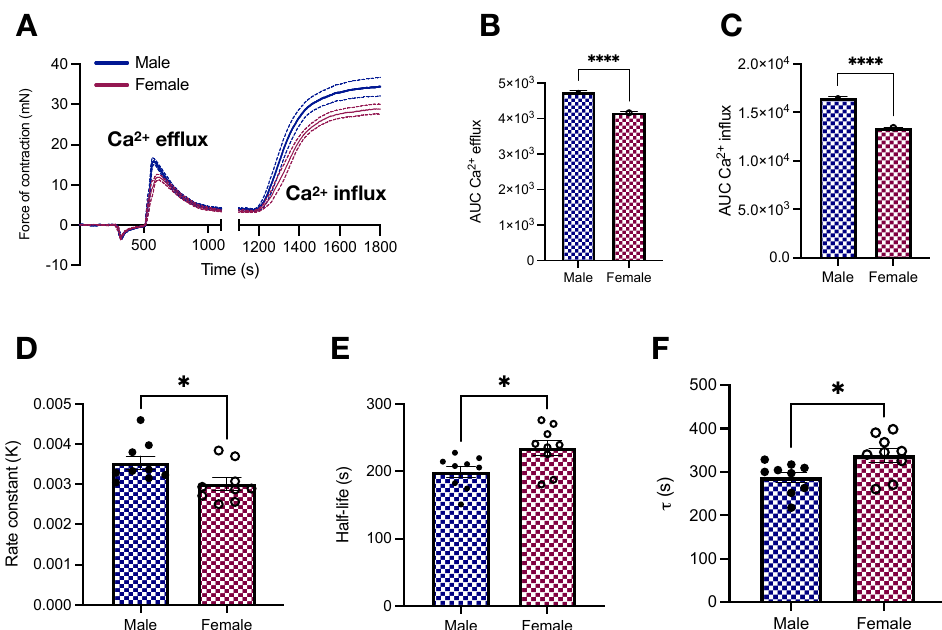
Figure 4. Vascular responses to calcium efflux and influx in male and female young Wistar rats. ( A ) Calcium protocol and ( B , C ) area under the curve. All samples were stimulated with phenyle- phrine (10 − 5 mol/L). In A, data points were sampled every second. The continuous line represents the mean, and the dashed lines depict SEM. The transient relaxation curves were fitted to a one-phase decay exponential model to reveal the rate constant κ ( D ), half-like ( E ), and τ ( F ). Data are presented as means ± SEM, n = 9–10. * p < 0.05 and **** p < 0.0001 using two-tailed Student’s t -test. 2.4. Elastin and Collagen Levels in the Aorta of Young Male and Female Wistar Rats The ECM, the non-cellular component of the vascular wall, contains fibrous proteins, including elastin and collagen [31]. Changes in ECM composition contribute to arterial stiffening [32]. Here, we indirectly assessed elastin and collagen levels with fluorescence microscopy and a picrosirius red staining kit, respectively. We found that, compared with female animals, male Wistar rats display a tendency towards higher levels of elastin (1,151,556.2 ± 104,838.1 vs. 888,221.4 ± 90,955.99 arbitrary units; p > 0.05, Figure 5A). No differences between sexes were observed for elastin fragmentation (10.08 ± 0.62 vs. 10.87 ± 1.36; male vs. female, p > 0.05, Figure 5B) nor the number of laminae (7.86 ± 0.35 vs. 7.8 ± 0.34; male vs. female, p > 0.05). On the other hand, we observed that male animals had enhanced collagen levels (Figure 5C). Differences were observed when we considered the total area of the vessel (17.22 ± 0.99 vs. 12.49 ± 0.92 %; male vs.